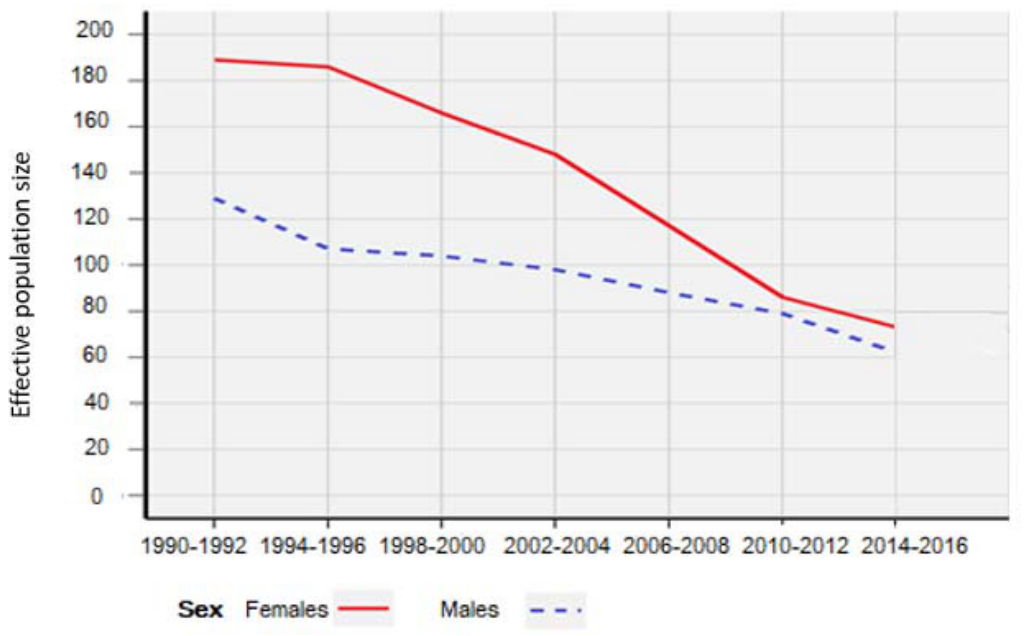
Figure 1. The e ff ective population size of the border collie Figure 1. The effective population size of the border collie breed.